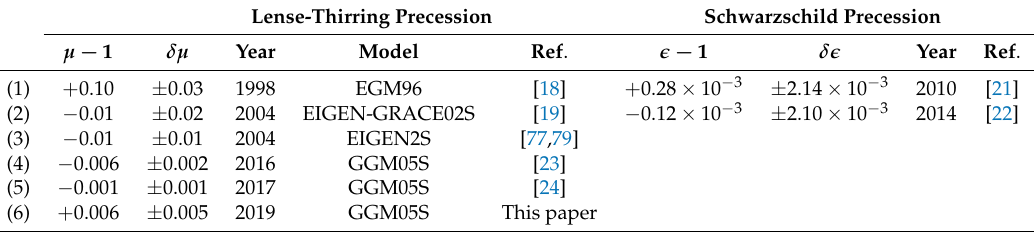
Table 8. Measurements of the Lense-Thirring secular precession due to the Earth gravitomagnetic field and of the Schwarzschild secular precession due to the Earth gravitoelectric field. The normalized Lense-Thirring precession µ was obtained: combining the nodes of the two LAGEOS with the pericenter of LAGEOS II in the case of the measurement (1); combining the nodes of the two LAGEOS for the measurements (2) and (3); combining the nodes of the two LAGEOS with that of LARES for the other measurements. In the case of the Schwarzschild precession (cid:101) , the pericenter of LAGEOS II was used as the relativistic